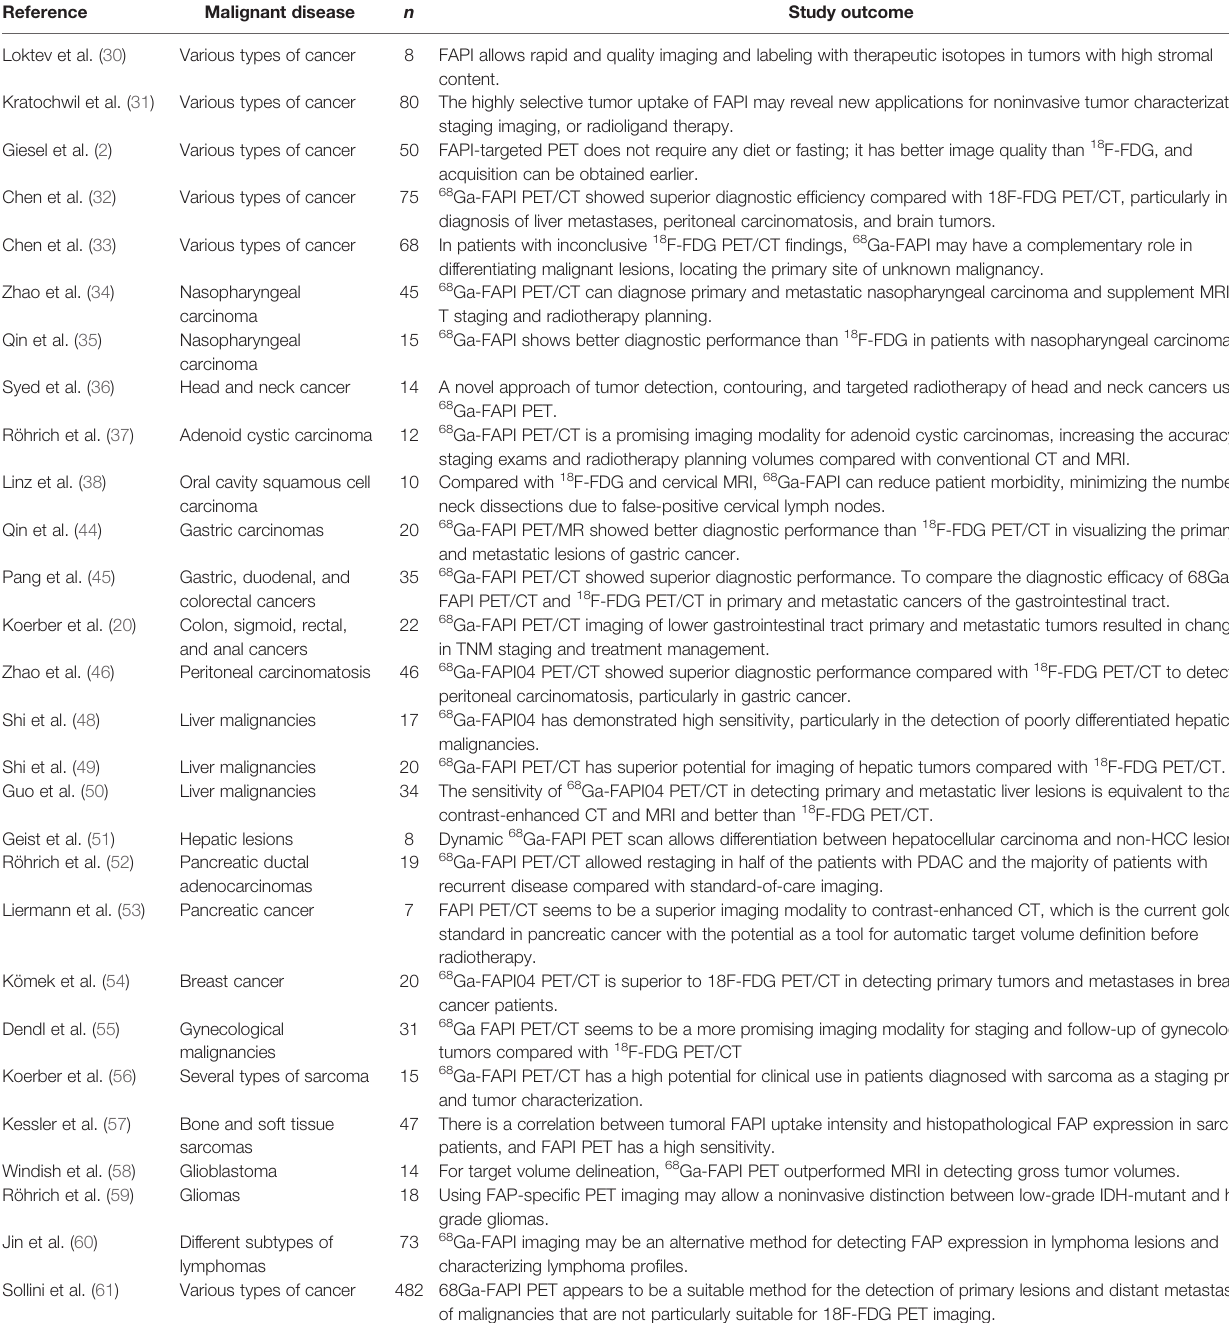
TABLE 1 | Summary of studies evaluating FAP-targeted imaging of various cancer